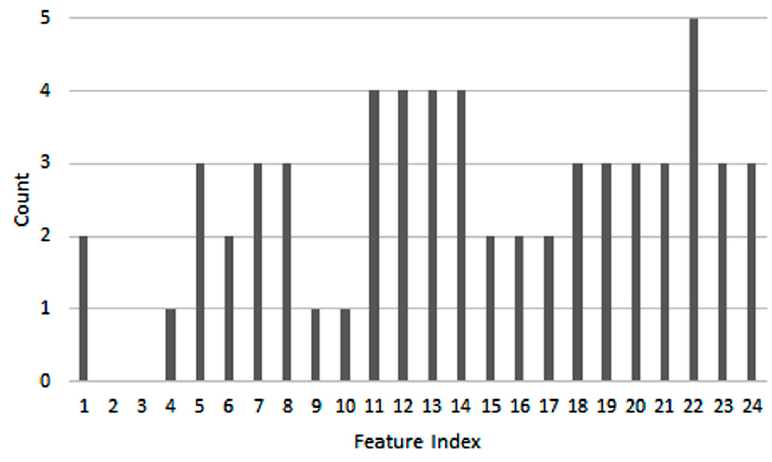
Figure 10. Feature histogram in the fittest chromosome.